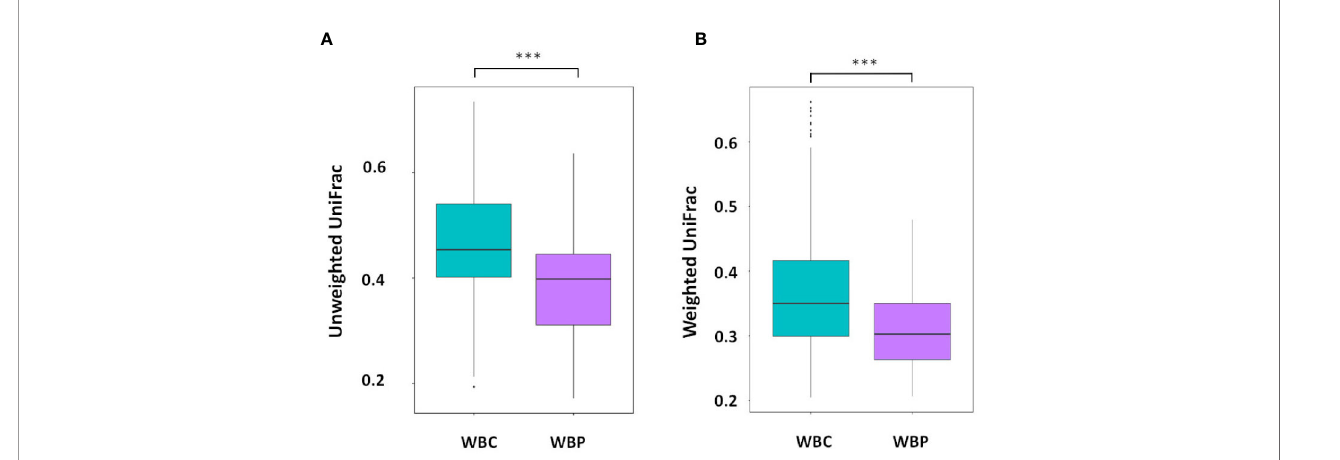
FIGURE 3 | Beta diversity: (A) Unweighted and (B) weighted UniFrac distances with signi fi cant differences between WBC and WBP, P value 0 (Wilcox). ***P < 0.001.